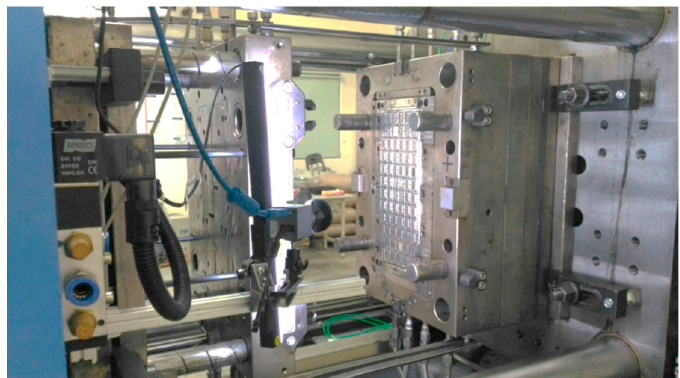
Figure 4. IC tray mold and injection molding